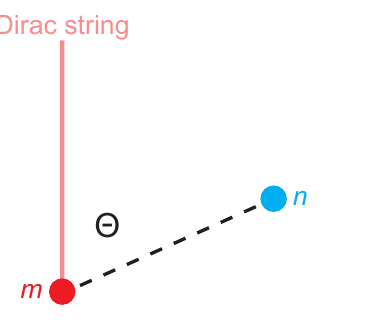
Figure 3: The statistical interaction in the Coulomb gas representation. If the monopole current, m µ ( R ) , describes a vortex string extending vertically in the z - direction, and n µ ( r ) describes a static charge with world line in the Euclidean “time” direction, τ , then Θ µν ( R − r ) is the angle r − R forms with the vortex world sheet in the ( x , y )